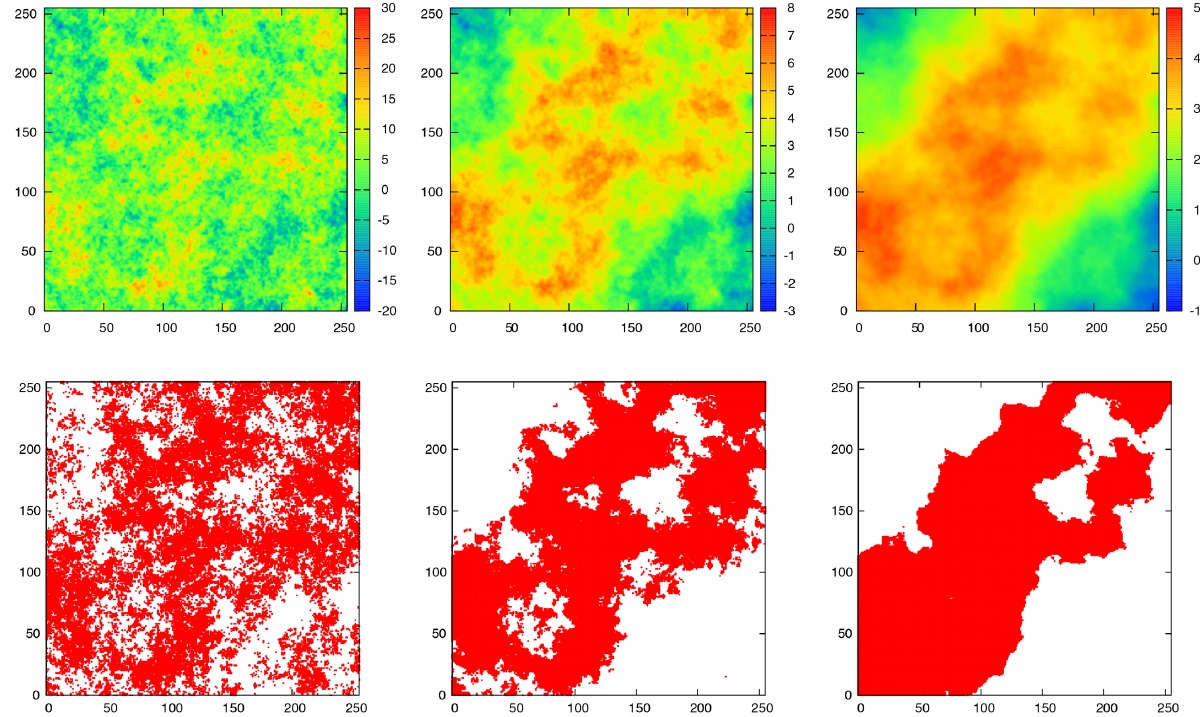
Figure 1. Instances of fragmented landscapes with varying degree of spatial autocorrelation. In the left panels the Hurst exponent is set at H ~ 0 : 01 , while for the middle and right panels its value is set at H ~ 0 : 5 and H ~ 0 : 9 respectively. In the upper panels the sites in a 256 | 256 grid are are color-coded according to an elevation scale X , with scale identifier shown along the right side bar. To each site in the grid corresponds a height, as provided by the fractional Brownian motion (fBm) algorithm. The lower panels are obtained from their corresponding configurations in the upper panels by fixing the fraction of suitable habitats at p ~ 0 : 5 .